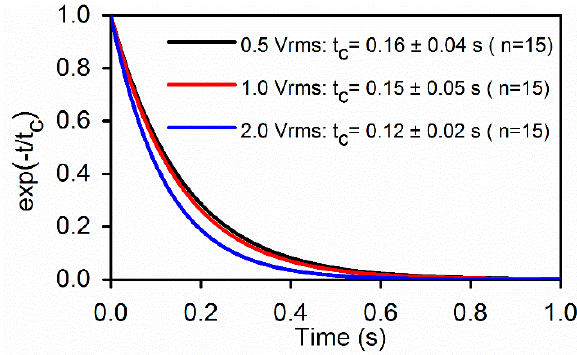
Figure 6. Best fit to the extensional recovery of RBC membranes ( n = 15). The averaged characteristic time was found to be t c = 0.14 ± 0.05 s for the three voltage levels.